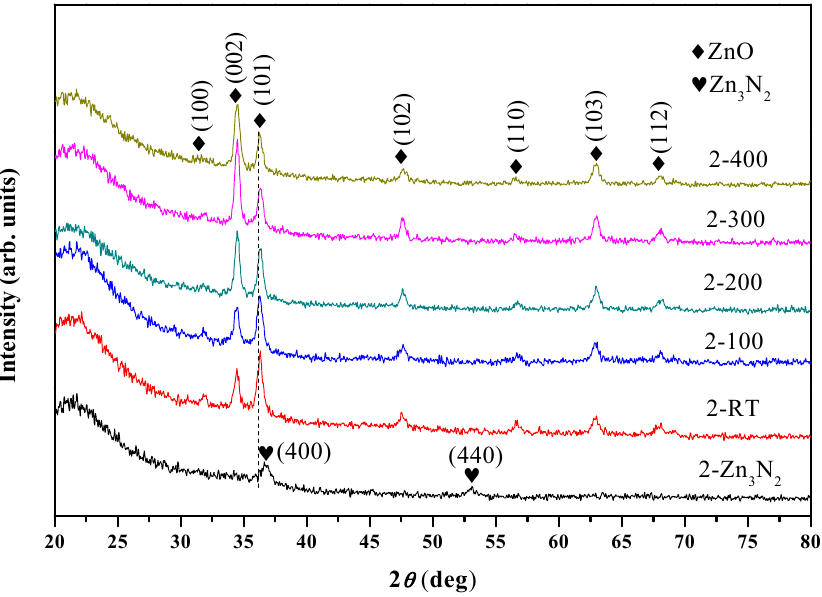
Figure 1. XRD patterns of as-grown 2-Zn 3 N 2 film and ZnO:N films (labels 2-Zn 3 N 2 and 2-RT/2-100/2-200/2-300/2-400 means that the Zn 3 N 2 film was grown at 200 °C and that the oxidizing temperatures are room temperature (RT), 100 °C, 200 °C, 300 °C, and 400 °C, respectively).